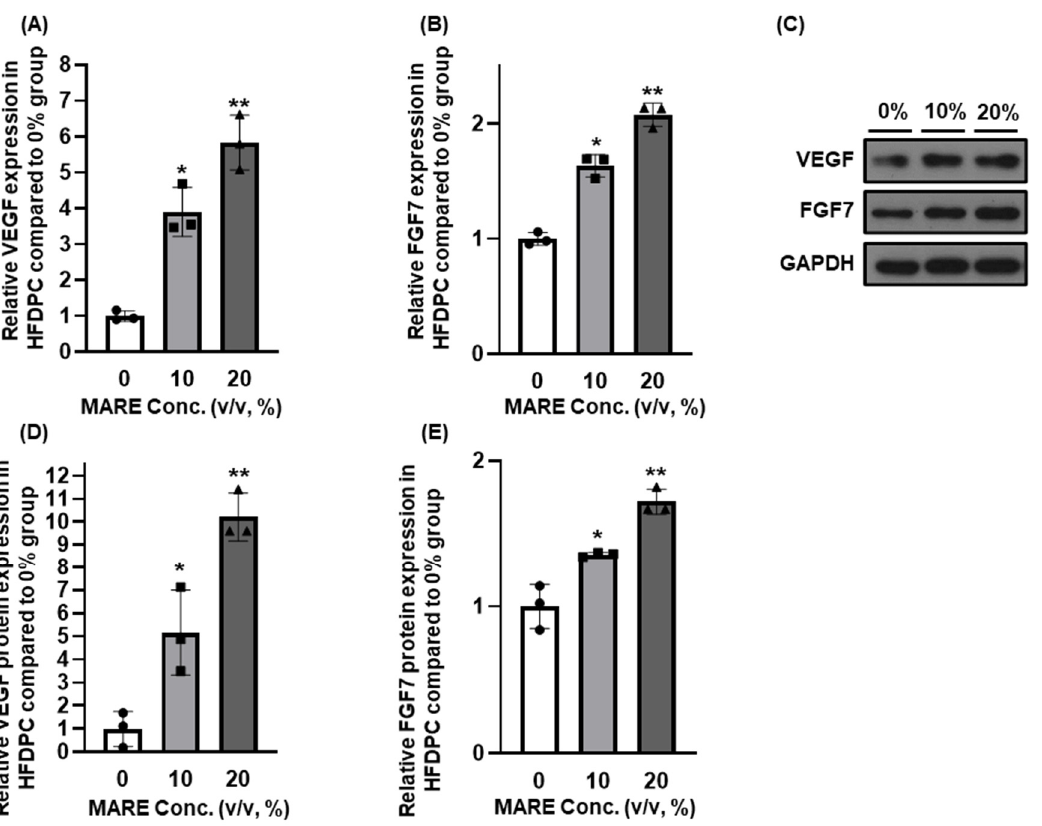
Figure 4. Effect of MARE on ( A ) vascular endothelial growth factor (VEGF), ( B ) fibroblast growth factor 7 (FGF7) ( n = 3, * p < 0.05, ** p < 0.001 compared to the 0% group). Representative results of ( C ) VEGF, FGF7 protein expression, and their ( D , E ) quantification ( n = 3, * p < 0.05, ** p < 0.001 compared to the 0% group).